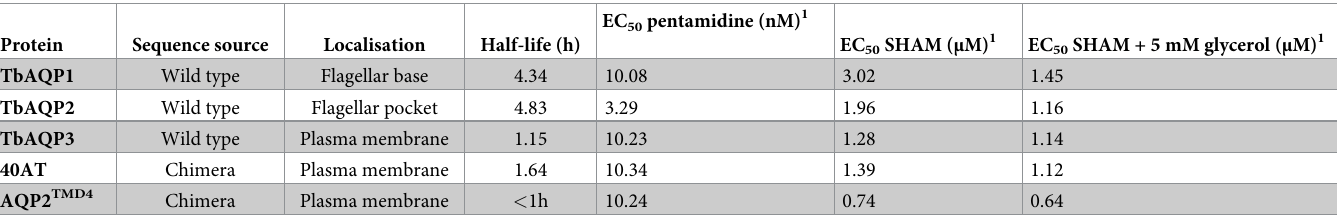
Table 2. Summary of the impact of chimerisation on TbAQP2 localisation and function. Protein Sequence